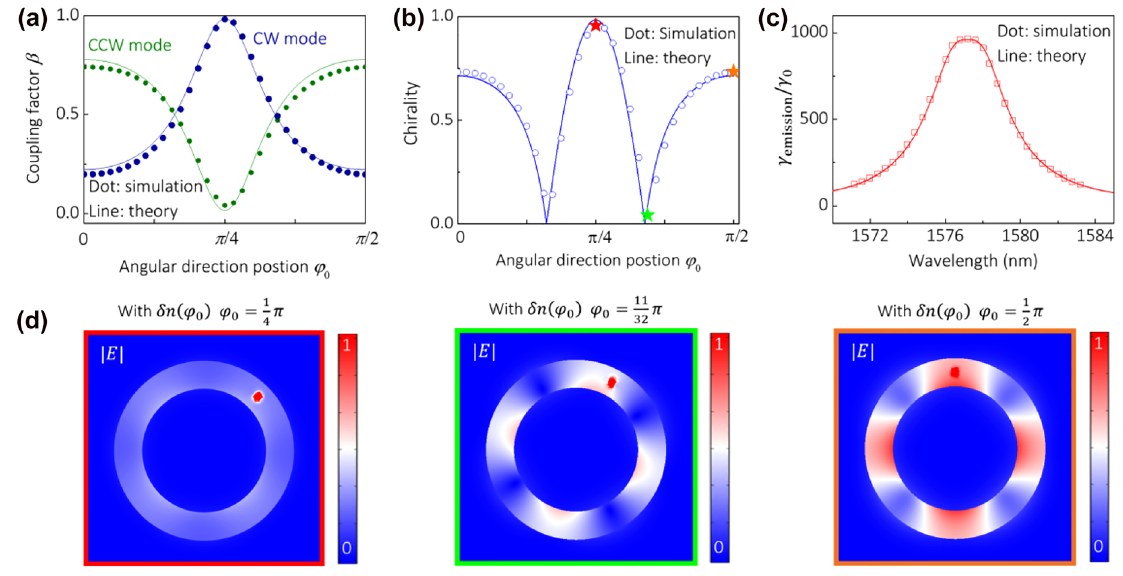
Figure 4: Chirality and radiation rate enhancement of a single emitter inside the CPN. (a) β and β as a function of the dipole position φ CW CCW its position φ . (c) Radiation rate acceleration factor γ 0 solid linesare obtainedby full wave simulationandcoupled mode theoryrespectively. (d)The electric fi eldexcited by a singleemitter located at different azimuthal